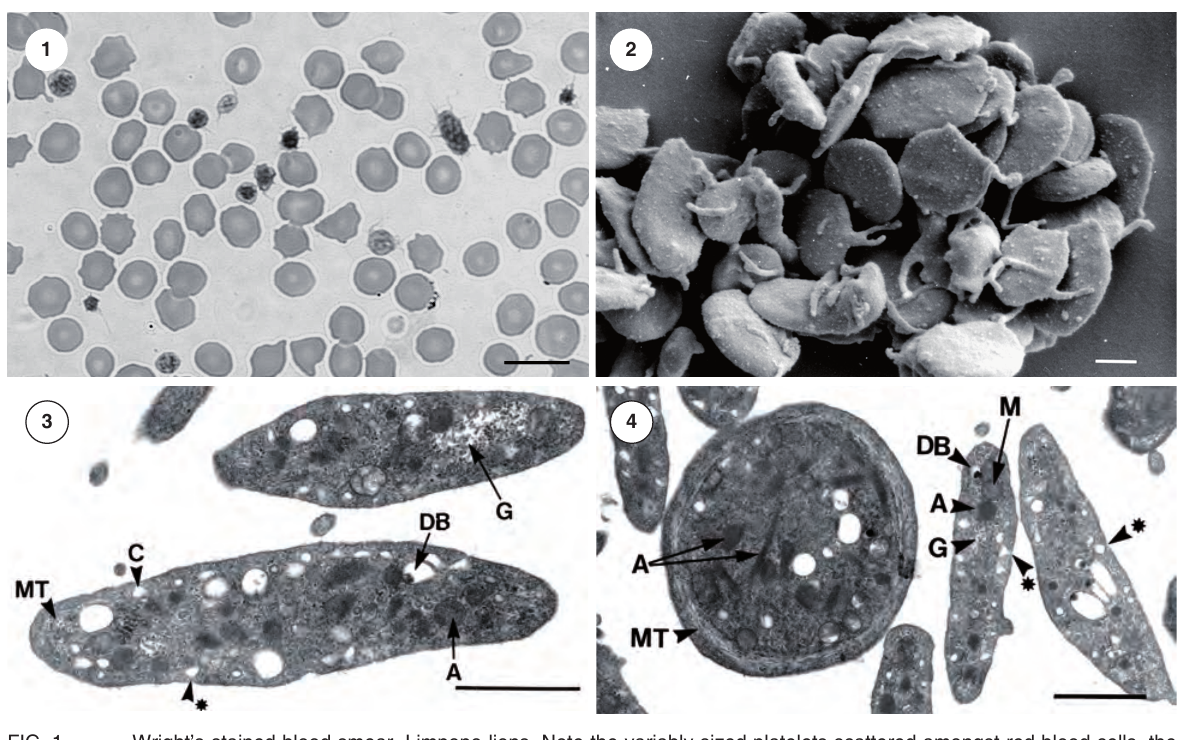
FIG. 1 Wright’s-stained blood smear, Limpopo lions. Note the variably sized platelets scattered amongst red blood cells, the presence of pseudopodia, and granules in the platelets. Bar = 10 µm FIG. 2 SEM image of platelets, KwaZulu-Natal lions. Platelets appear as bilaterally flat tened discs with pseudopodia. Bar = 1 µm FIG. 3 and 4 TEM images of platelets, KwaZulu-Natal lions. A few canaliculi (C) can be seen opening onto the cell surface (*). Note the different shapes of the a -granules (A). Microtubules (MT), dense bodies (DB), glycogen granules (G) and mitochon- dria (M) are clearly visible in the cytoplasm. Bar = 1 µm TABLE 1 Platelet measurements (mean ±